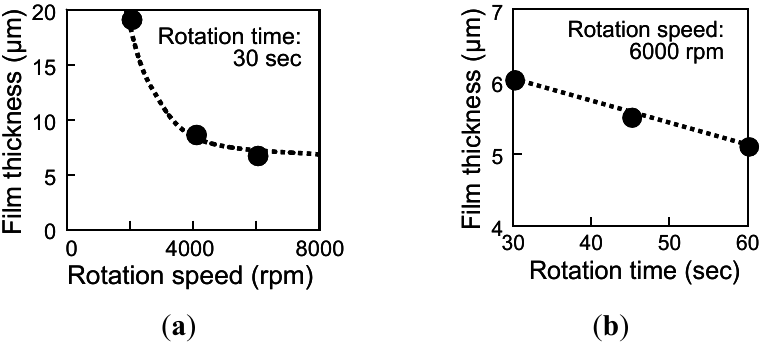
Figure 4. ( a ) Rotation speed dependence and ( b ) rotation time dependence of film thickness of polyurethane.